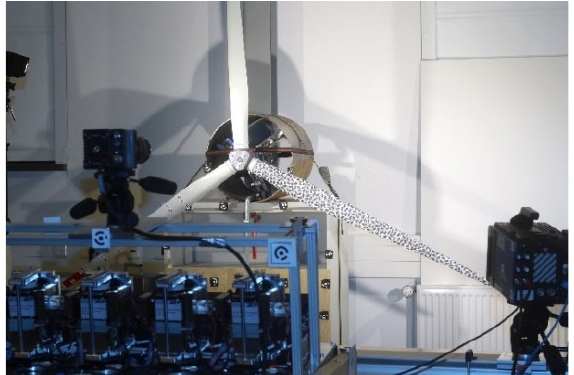
Figure 19. Exemplary test setup for measuring moving rotor blades in the